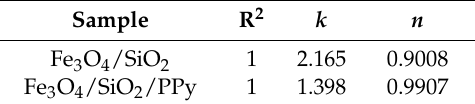
Table 3. Parameters of Korsmeyer-Peppas model for IBU release under